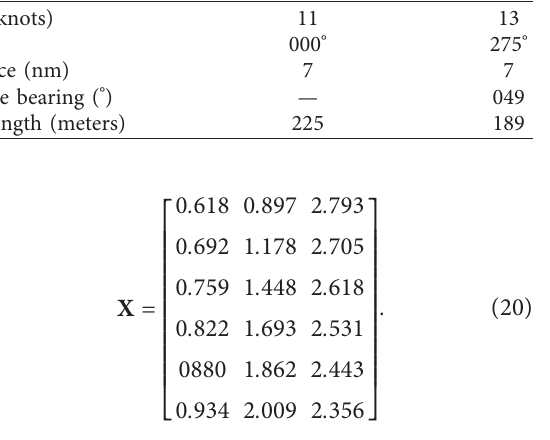
Table 1: Scenario I: encounter information.